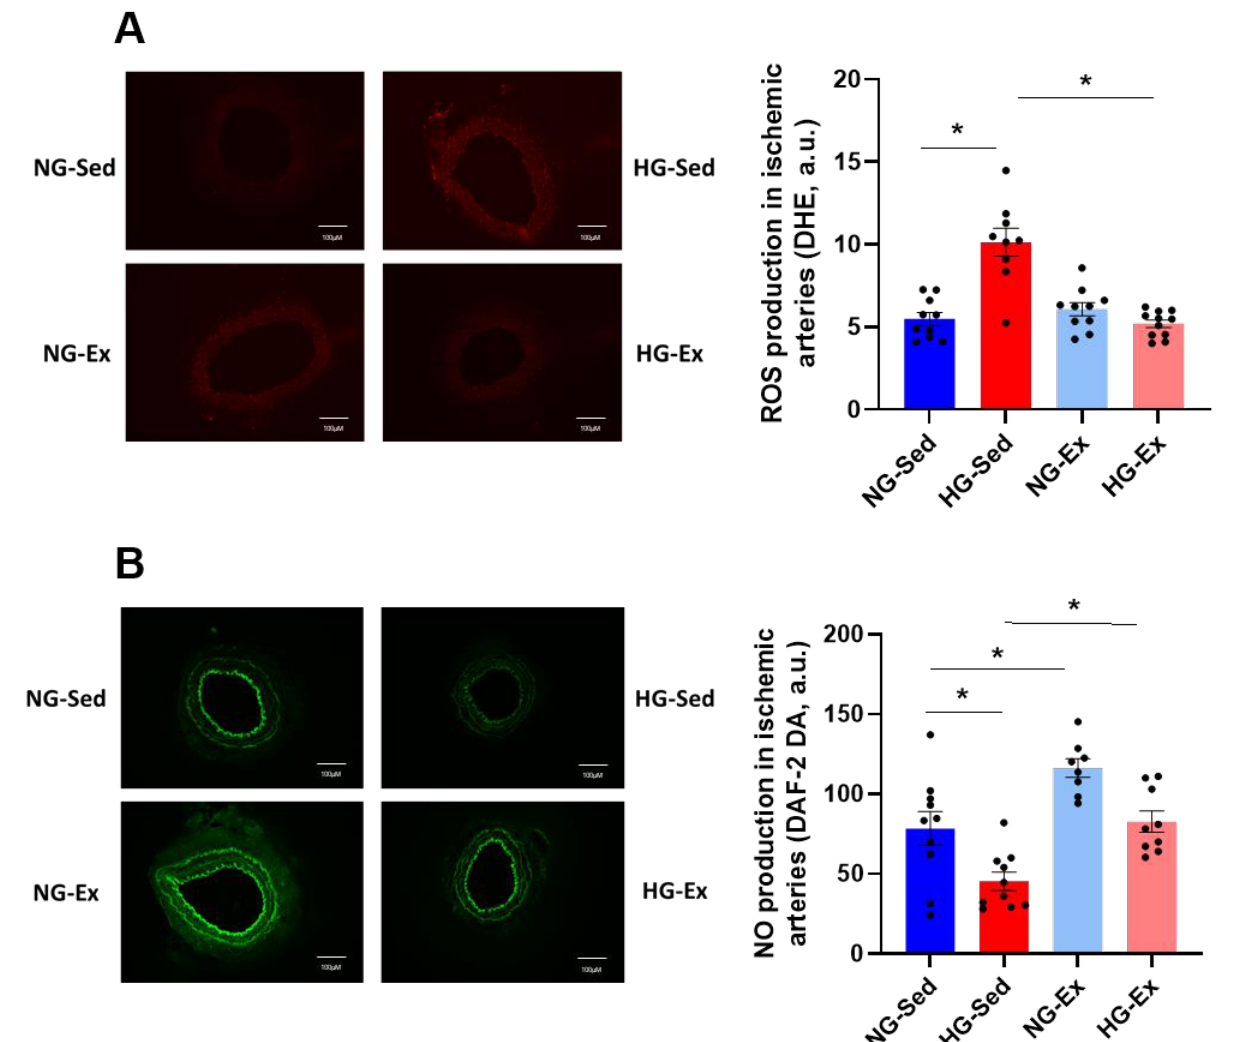
Figure 4. Normalization of reactive oxygen species and nitric oxide production contributes to the beneficial effects of exercise training on vascular function. ( A ) Reactive oxygen species production evaluated using dihydroethidium (DHE) incubation (5 min, 100 µM) on femoral artery rings following the ischemia-reperfusion protocol. Reactive oxygen species levels in each group were quantified using ImageJ software. ( B ) NO levels evaluated using the NO-sensitive fluorescent dye 4,5-diaminofluorescein diacetate (DAF-2, 60 min, 10 µ M) on femoral artery rings following the ischemia-reperfusion protocol. NO levels in each group were quantified using ImageJ software. Fluorescence microscopy and digital image acquisition were carried out using an EVOS M5000 (Thermo Fischer Scientific, Waltham, Massachusetts, USA). Left panels represent illustrations of fluorescence photographs and right panels represent the quantification of reactive oxygen species and nitric oxide levels. n = 8–10 ischemic femoral rings from 4–5 rats per group. NG: normoglycemic; Sed: sedentary; the mean ± SEM. Comparisons of multiple experimental conditions were performed using analysis of variance (ANOVA) followed by Tukey ’s post hoc test.